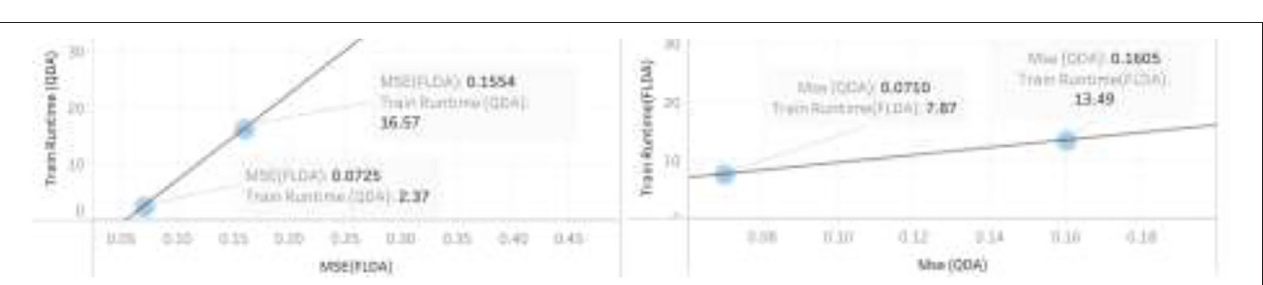
FIGURE 14 | Sensitivity analysis of mean standard error using both QDA and FLDA